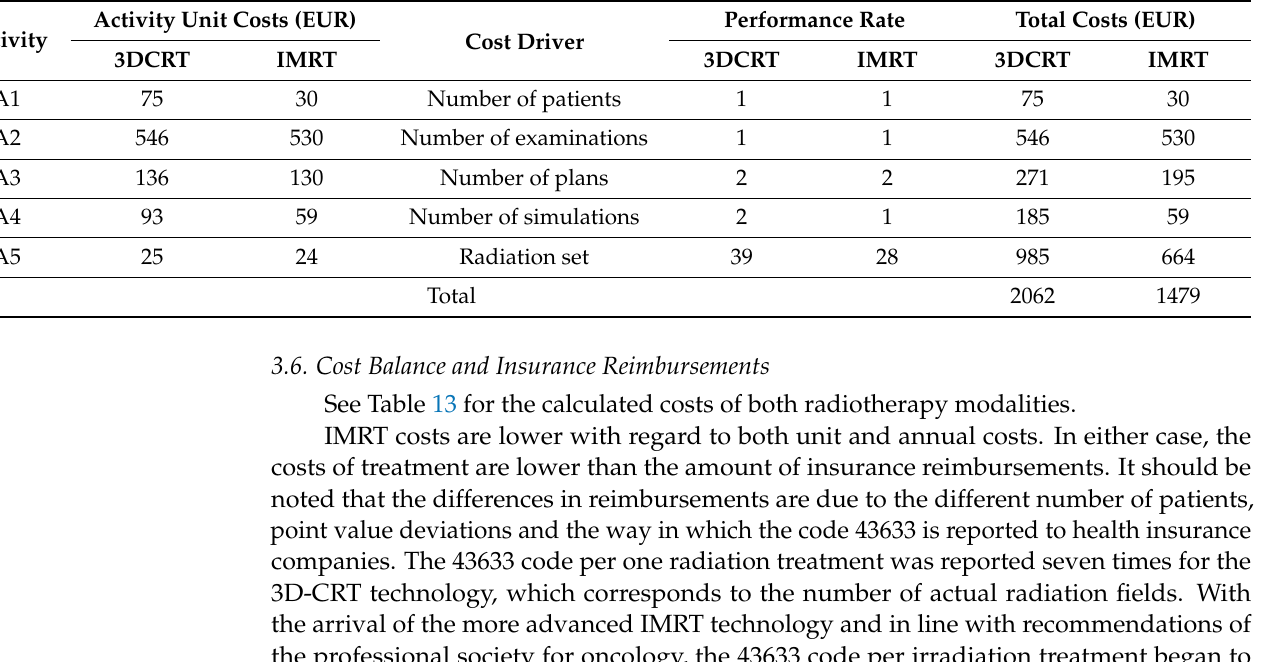
Table 12. Costing sheet—1 patient with